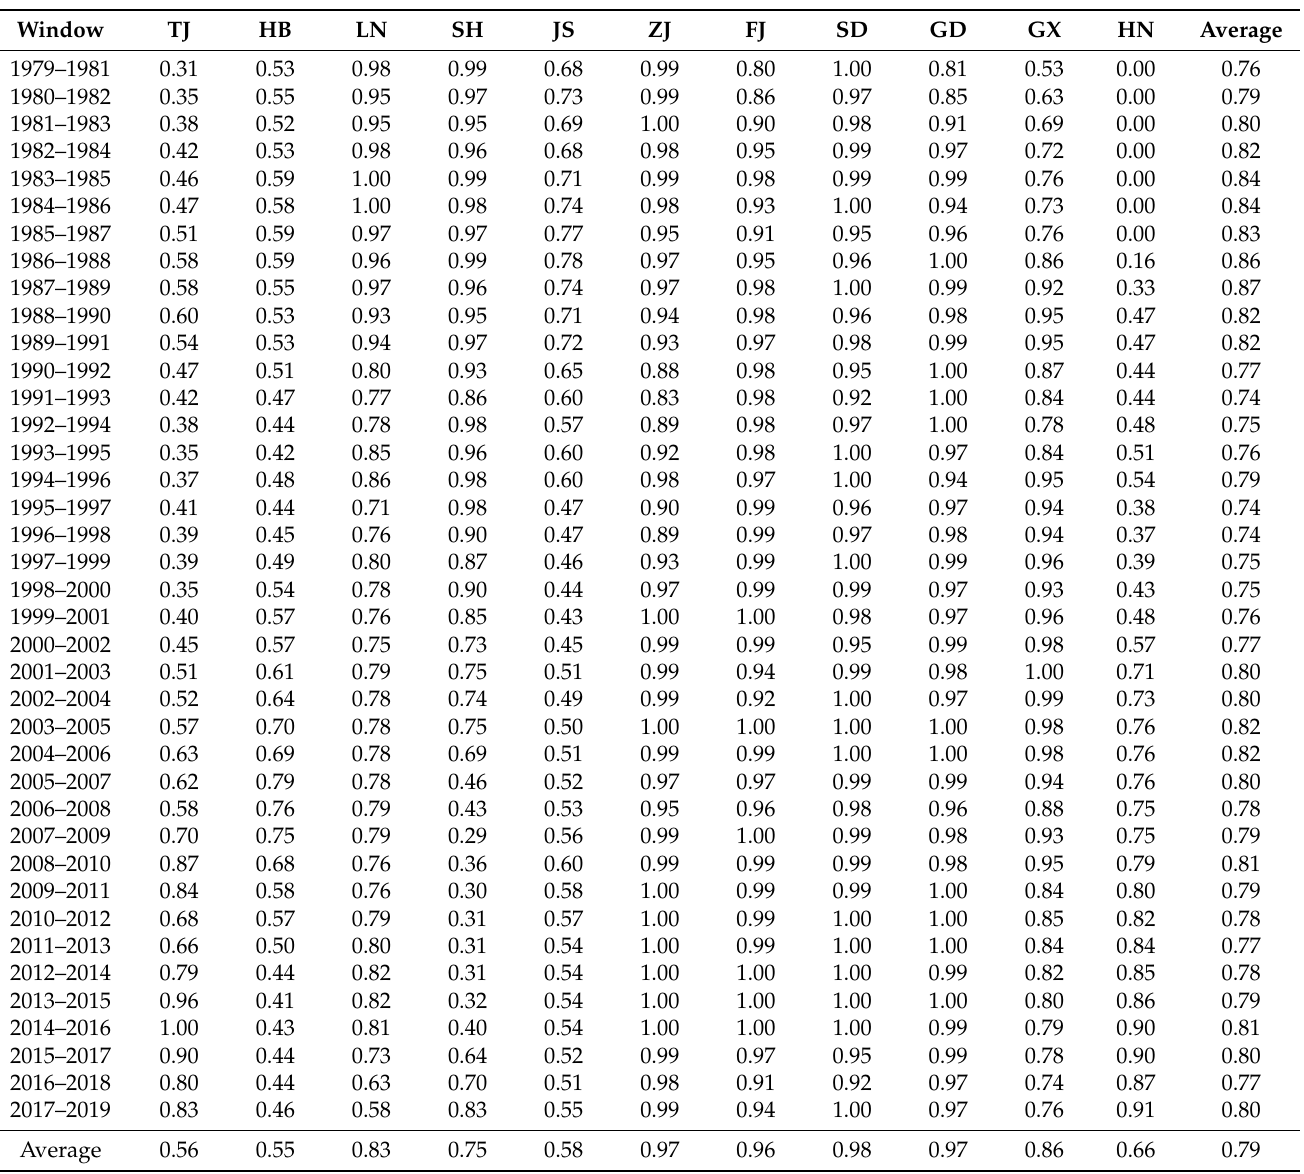
Table 1. Results of window-DEA, per region. [Tianjin (TJ), Hebei (HB), Liaoning (LN), Shang- hai (SH), Jiangsu (JS), Zhejiang (ZJ), Fujian (FJ), Shandong (SD), Guangdong (GD), Guangxi (GX), Hainan